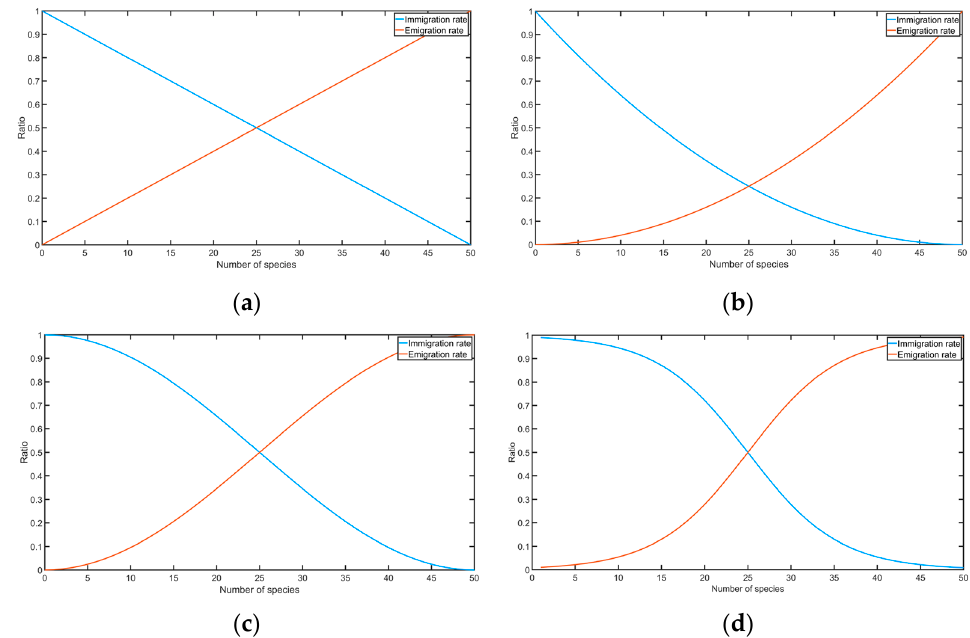
Figure 6. ( a ) Transition plot for a linear function model; ( b ) transition plot for quadratic function model; ( c ) transition plot for the cosine function model; ( d ) transition plot for hyperbolic tangent function model.